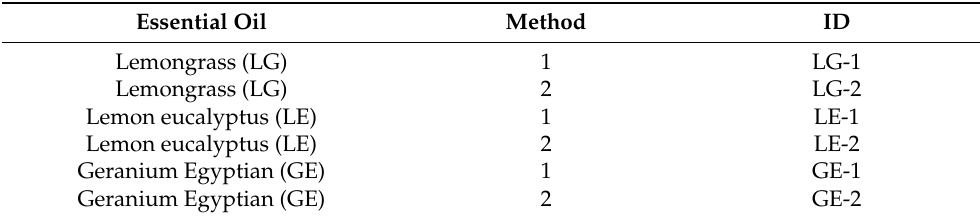
Table 1. Summary of essential oils and synthetic methods used to prepare β -cyclodextrin inclu- sion complexes. Essential Oil Method ID Lemongrass (LG) 1 LG-1 Lemongrass (LG) 2 LG-2 Lemon eucalyptus (LE) 1 LE-1 Lemon eucalyptus (LE) 2 LE-2 Geranium Egyptian (GE) 1 GE-1 Geranium Egyptian (GE) 2